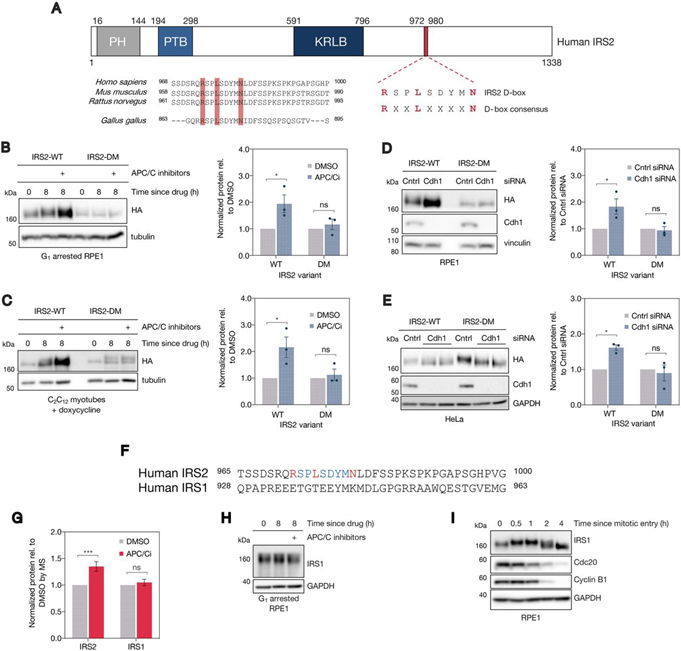
Cdh1's ability to control IRS2 levels depends on a C-terminal d-box motif.A, (top) Schematic depicting IRS2's protein domain structure. PH = pleckstrin homology domain, PTB = phosphotyrosine binding domain, KRLB = kinase regulatory-loop binding region. IRS2's C-terminal full d-box motif is highlighted in red. (bottom) Comparison of IRS2's D-box conservation among amniotes. B, RPE1 cells stably expressing lentivirus-derived, doxycycline-inducible, C-terminally HA-tagged IRS2 constructs were arrested in G1 with palbociclib for 20 h. Following arrest, samples were either collected or DMSO or APC/C inhibitors were added for an additional 8 h. Quantification of immunoblots shown at right: HA levels were normalized to a loading control and are plotted relative to DMSO levels. Error bars = mean ± S.E. *: p = 0.0187; ns: p = 0.816. C, C2C12 myoblasts stably expressing lentivirus-derived, doxycycline-inducible, C-terminally HA-tagged IRS2 constructs were grown to confluence and switched to low serum media supplemented with ITS (differentiation media) and doxycycline. Cells were allowed to differentiate into myotubes for 3 days (with media refreshment every 24 h), at which point (0 h) either DMSO or APC/C inhibitors for an additional 8 h in the presence of doxycycline. Quantification of immunoblots shown at right: HA levels were normalized to a loading control and are plotted relative to DMSO levels. Error bars = mean ± S.E. *: p = 0.0118; ns: p = 0.910. D, Asynchronous RPE1 cells stably expressing lentivirus-derived, doxycycline-inducible C-terminally HA-tagged IRS2 constructs were transfected with a nontargeting (control) siRNA or an siRNA directed against Cdh1 for 24 h in the absence of doxycycline. Quantification of immunoblots shown at right: HA levels were normalized to a loading control and are plotted relative to DMSO levels. Error bars = mean ± S.E. *: p = 0.0132; ns: p = 0.963. E, Asynchronous HeLa cells stably expressing lentivirus-derived, N-terminally FLAG-HA tagged IRS2 constructs were transfected with a nontargeting (control) siRNA or an siRNA directed against Cdh1 for 24 h. Quantification of immunoblots shown at right: HA levels were normalized to a loading control and are plotted relative to DMSO levels. Error bars = mean ± S.E. *: p = 0.0131; ns: p = 0.803. F, Comparison of the Hs IRS2 D-box sequence with the corresponding region from Hs IRS1. G, MS-quantified IRS1 and IRS2 abundance in G1 APC inhibitor proteomics (Fig. 1). IRS1 abundance was quantified based on 5 peptides (4 unique) in 3 biological replicates; IRS2 was quantified based on 3 peptides (all unique) in 3 biological replicates. H, RPE1 cells were subject to the same conditions described in Fig. 1A, and cell lysates were analyzed by immunoblotting for IRS1 abundance I, RPE1 cells were treated as in Fig. 3C. Cell lysates were analyzed by immunoblotting for IRS1 abundance.